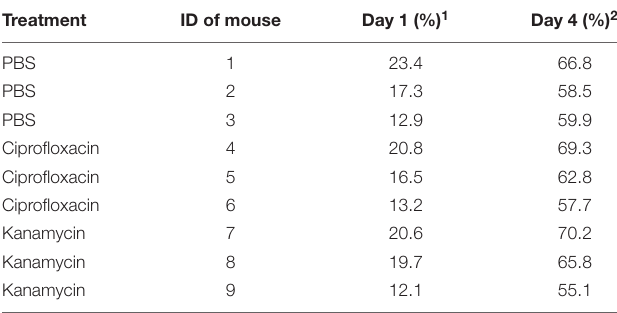
TABLE 3 | Parasitemia density of B. microti in mice at different time points after infestation with PBS- or antibiotic-treated R. haemaphysaloides ticks. Treatment